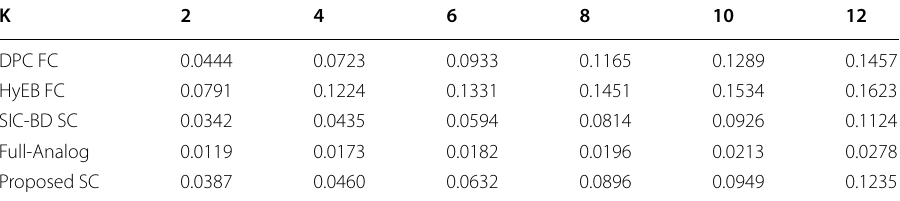
Table 2 The running time of five schemes (unit, second)